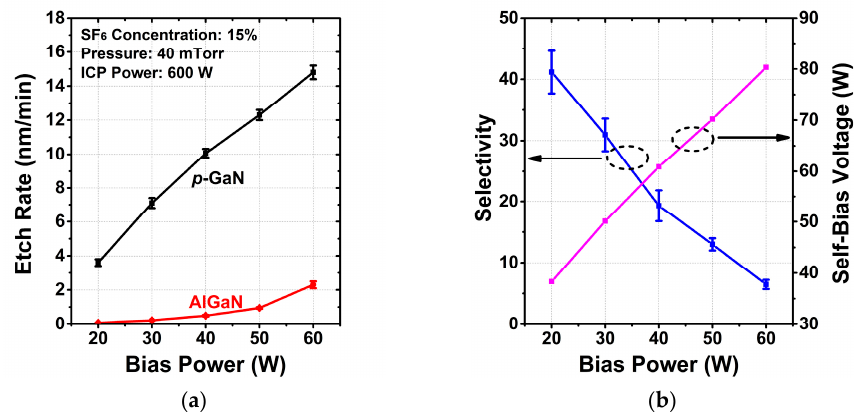
Figure 4. Dependence of ( a ) the etch rates, ( b ) selectivity between p -GaN and AlGaN and self-bias voltage on bias power.